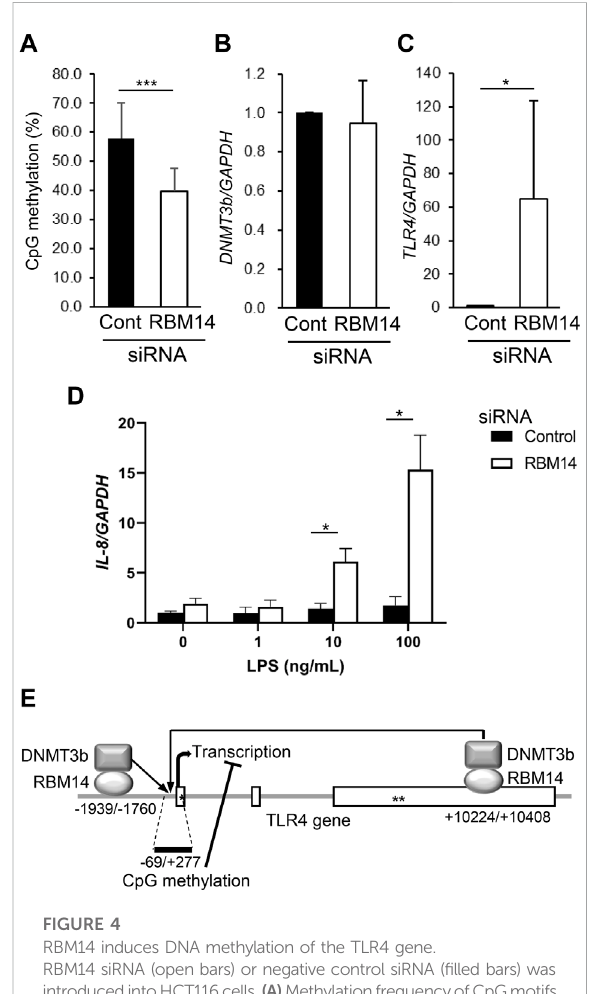
FIGURE 4 RBM14 induces DNA methylation of the TLR4 gene. RBM14 siRNA (open bars) or negative control siRNA ( fi lled bars) was introducedintoHCT116cells. (A) MethylationfrequencyofCpGmotifs presentinthent-69/+277regionoftheTLR4genewasanalyzed by bisul fi te sequencing. Sequences of total 17 (RBM14 siRNA) and 18 (negative control siRNA) clones obtained from three independent experimentswereanalyzed.***Signi fi cantlydifferent( p < 0.0001). (B) DNMT3b mRNA expression was determined by qRT-PCR. Relative expression levels to control cells are shown as mean ± SD of three independent experiments. (C) TLR4 mRNA expression was determinedbyqRT-PCR.Relativeexpressionlevelstocontrolcellsare shownasmean±SDofthreeindependentexperiments.*Signi fi cantly different ( p < 0.05). (D) Induction of IL-8 mRNA expression upon LPS stimulation was analyzed by qRT-PCR. Results are shown as mean ± SD of three independent experiments. * Signi fi cantly different ( p < 0.05). (E) Schematic diagram of the interaction of RBM14 with the TLR4 gene and DNMT3b underlying the induction of TLR4 gene methylation. Openboxes and asterisks (* and **)represent the exons, start codon, and stop codon, respectively.